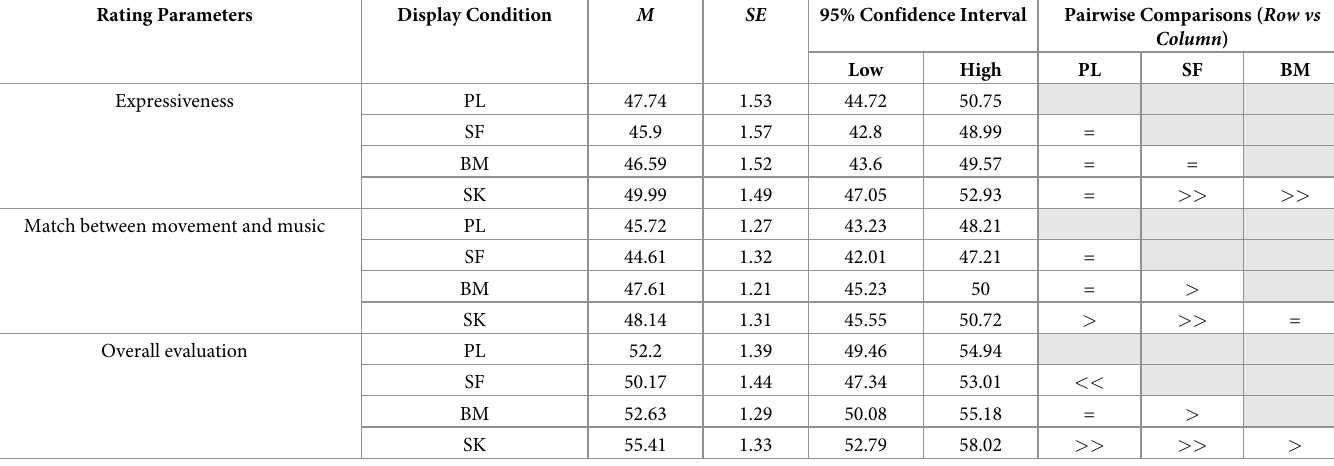
Table 1. Descriptive statistics and pairwise comparisons of each dependent variable across display conditions. Rating Parameters